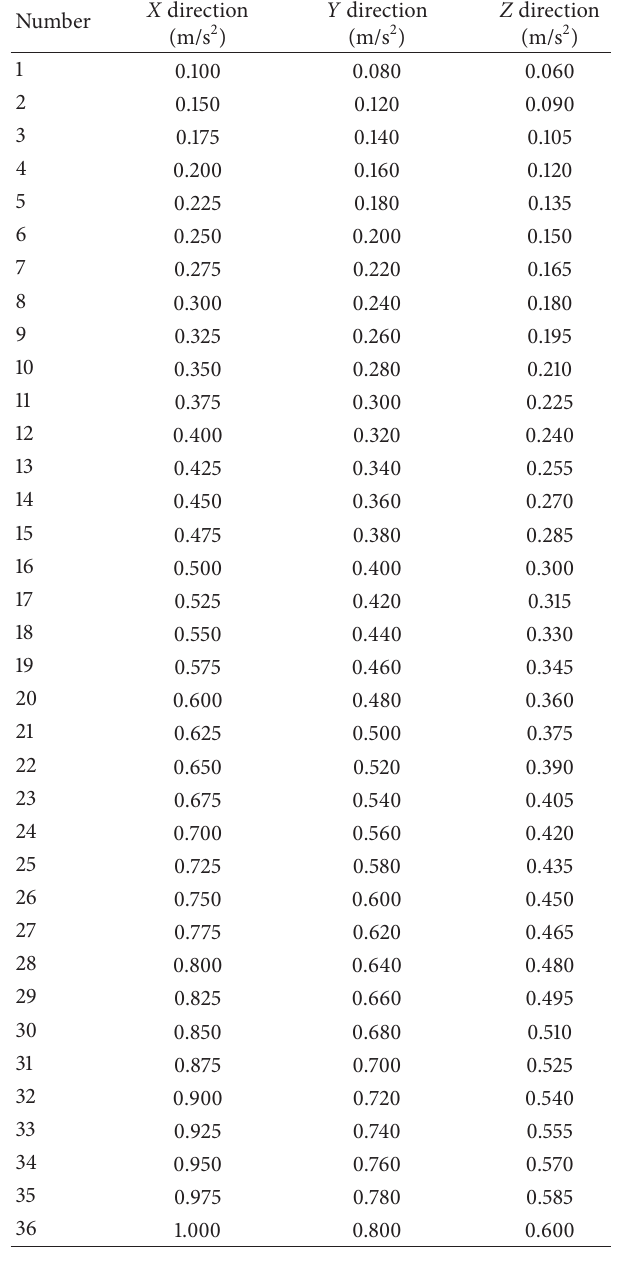
Table 2: The values of the load